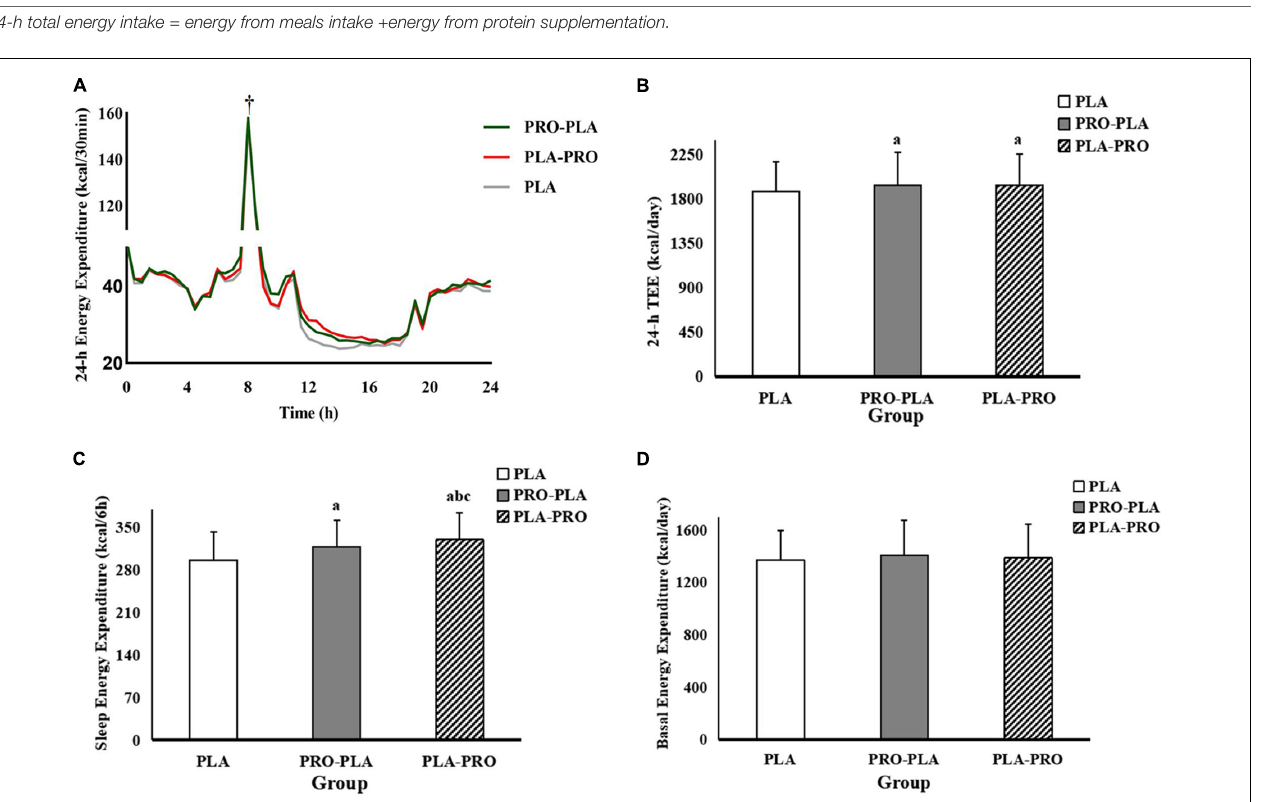
FIGURE 3 | The 24-h Continuous dynamic energy expenditure (A) , total energy expenditure (TEE, B ), sleep energy expenditure (SEE, C ), and basal energy expenditure (BEE, D ) in PRO-PLA, PLA-PRO, and PLA. † Peak energy expenditure caused by resistance exercise. a p < 0.05 PLA-PRO, PRO-PLA VS PLA, b p < 0.05 PLA-PRO VS PRO-PLA, adjusted for age, sex, %fat, relative VO 2max , sleep quality, the time of sedentary behavior and moderate and vigorous intensity physical activity in the pre-experiment stage, resistance energy expenditure under each condition (model 1); c p < 0.05 PLA-PRO VS PRO-PLA, additionally adjusted for 24-h total energy intake based on model 1 (model